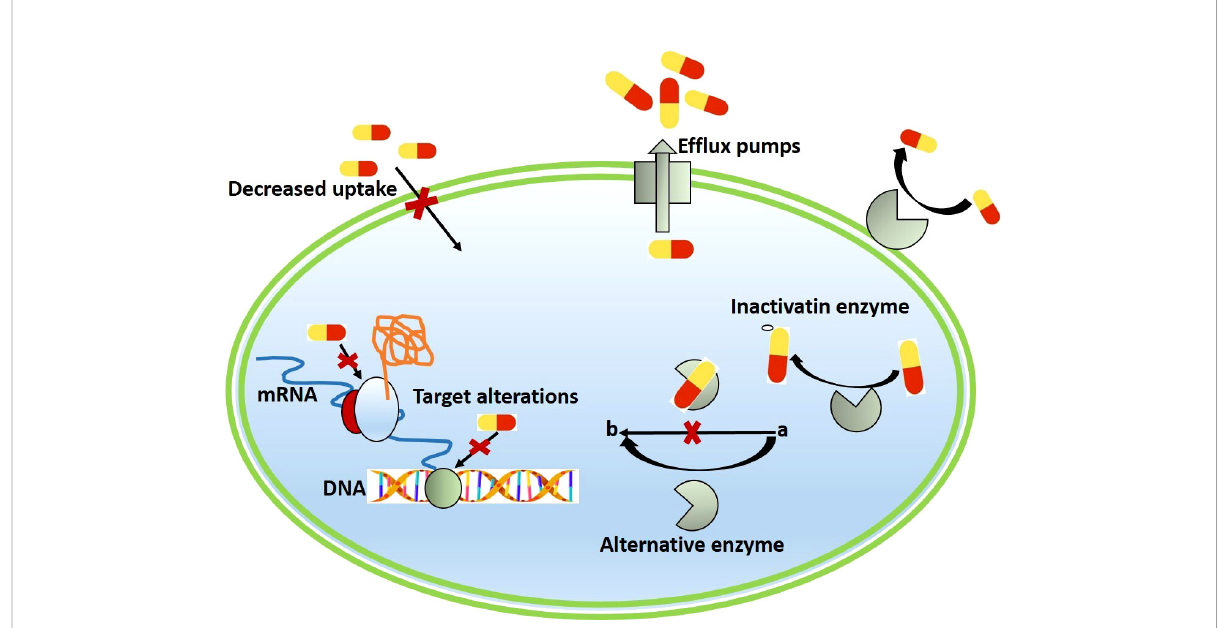
FIGURE 2 Schematic representation of different mechanisms of antimicrobial resistance in bacterial antibiotic